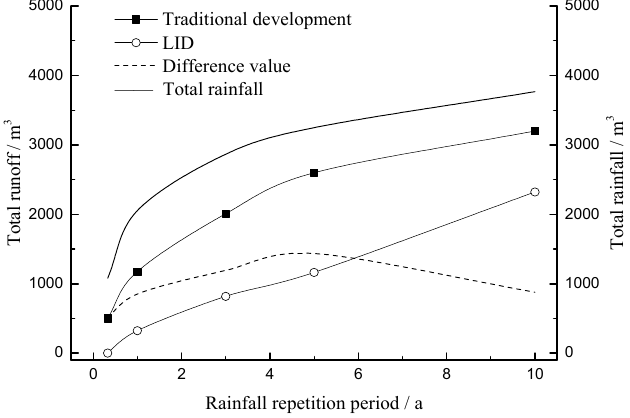
Figure 7. Rainfall curve under different rainfall intensities.